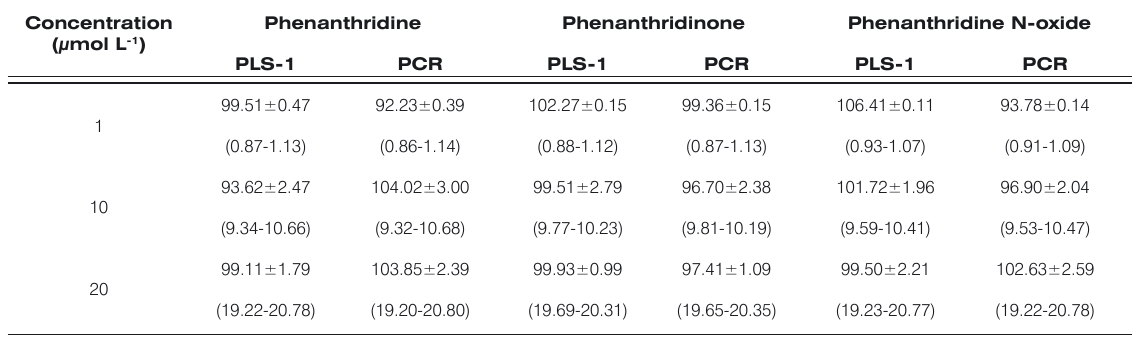
* The data are expressed as mean ± standard deviation. Values in parentheses represent 95% confidence